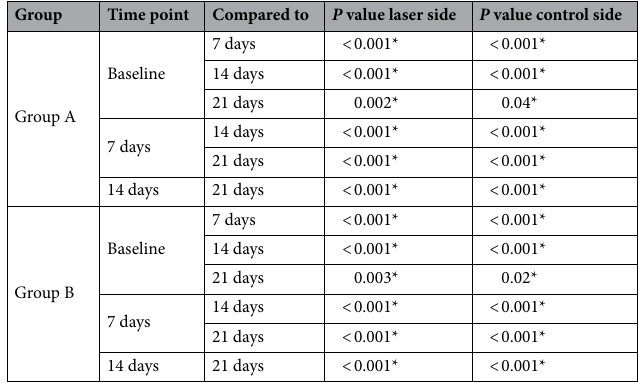
Table 6. Post-hoc pairwise comparisons of IL-1β levels at different time points, within the laser and control sides of each study group. *Statistically significant using Bonferroni adjusted significance level.